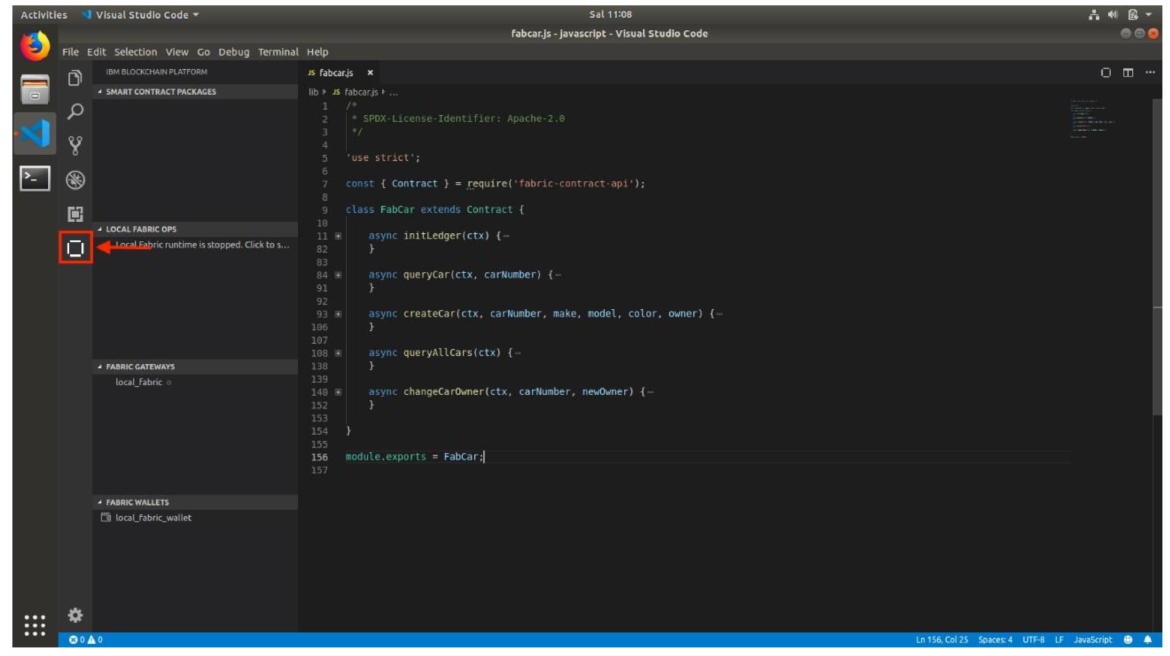
Figure 11. IBM blockchain platform “VS Code” plugin.